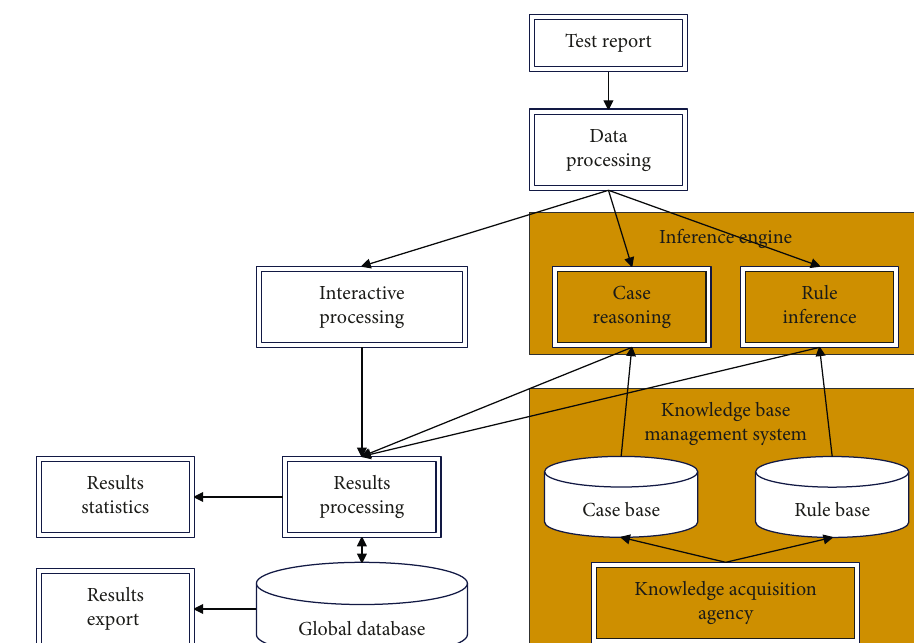
Figure 6: Overall model diagram of the international Chinese education expert system.